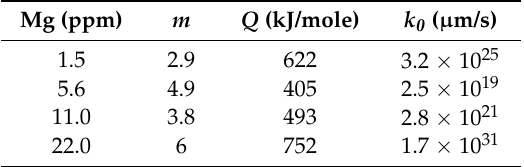
Table 3. Parameters of the fitting equations for steel with Mg content of 1.5-22.0 ppm using Equation (2).